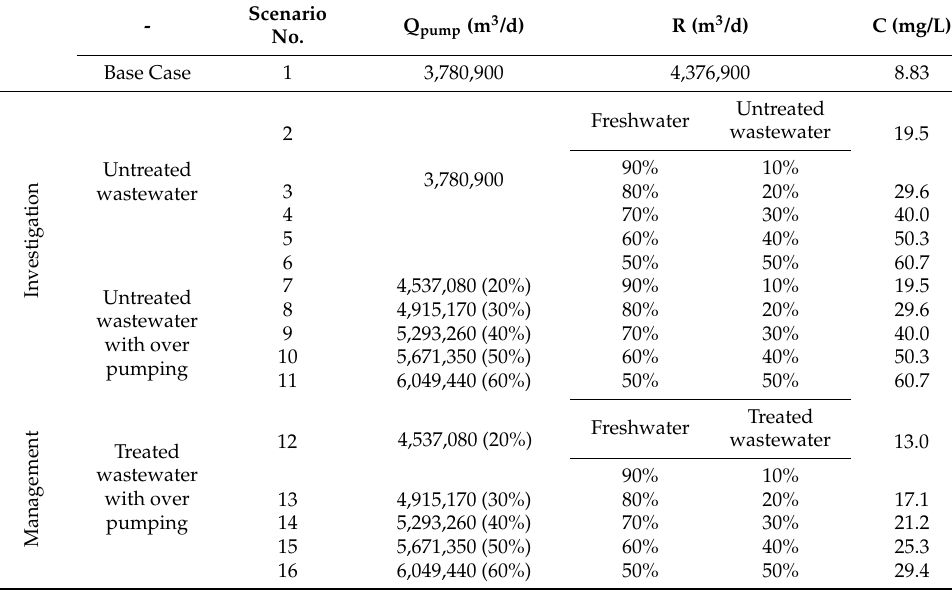
Table 3. Proposed scenarios applied for the ENDA.